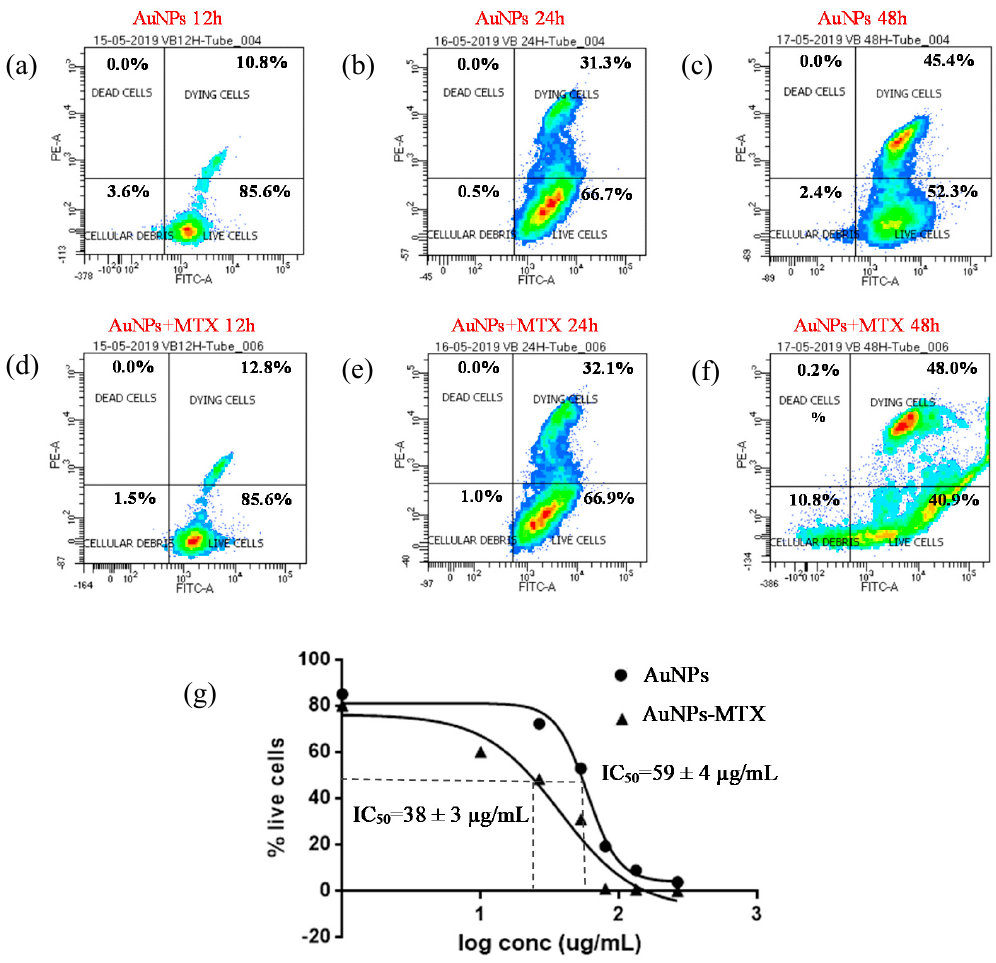
Figure 9. Percentage of cell viability for AuNPs and AuNP–MTX400 equivalent concentrations obtained by flow cytometry for the HTC-116 cell line after 12 ( a – d ), 24 ( b – e ) and 48 ( c – f ) h of incubation. ( g ) Calculated IC 50 for equivalent concentrations of AuNPs and AuNP–MTX400 after 48 h of incubation.